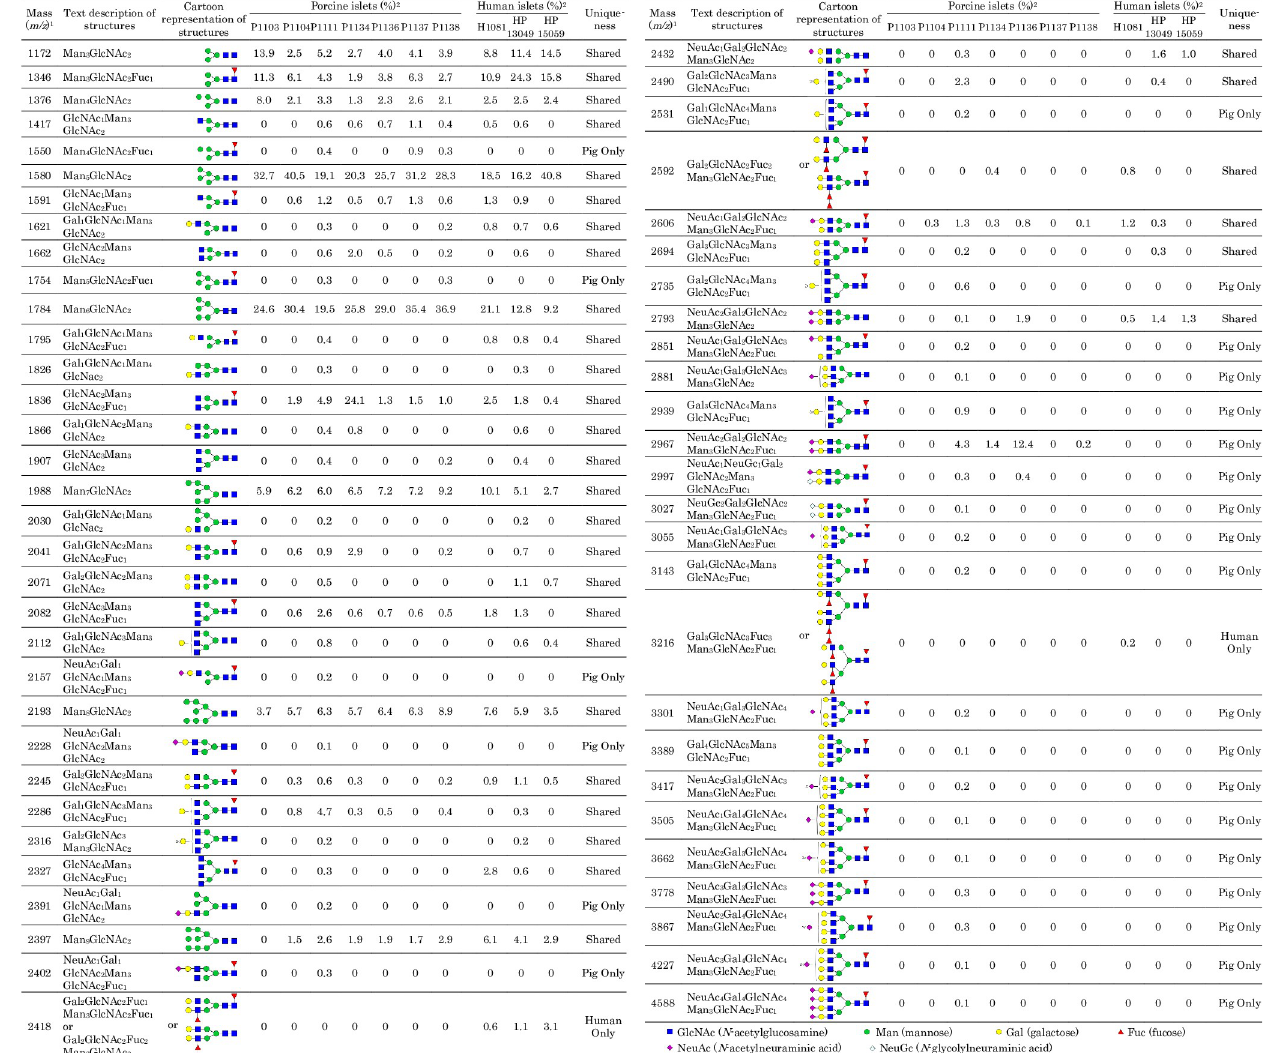
Fig 2. Summary of N-linked glycans detected from adult porcine and human islets by MALDI-TOF-MS and ESI-MS. The structures were confirmed by ESI-MS/MS. 1 All masses (mass+Na) are permethylated and single-charged values measured by MALDI-TOF-MS. The structure assignment were based on common biosynthetic pathway and ESI-MS/MS fragmentation by HCD. 2 % N -glycans were calculated from the area units of detected N -glycans.